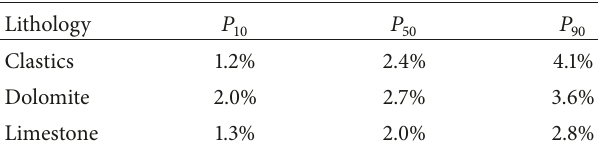
and 𝐶 of different types of coal CO 2 / CH 4 CO 2 / CH 4